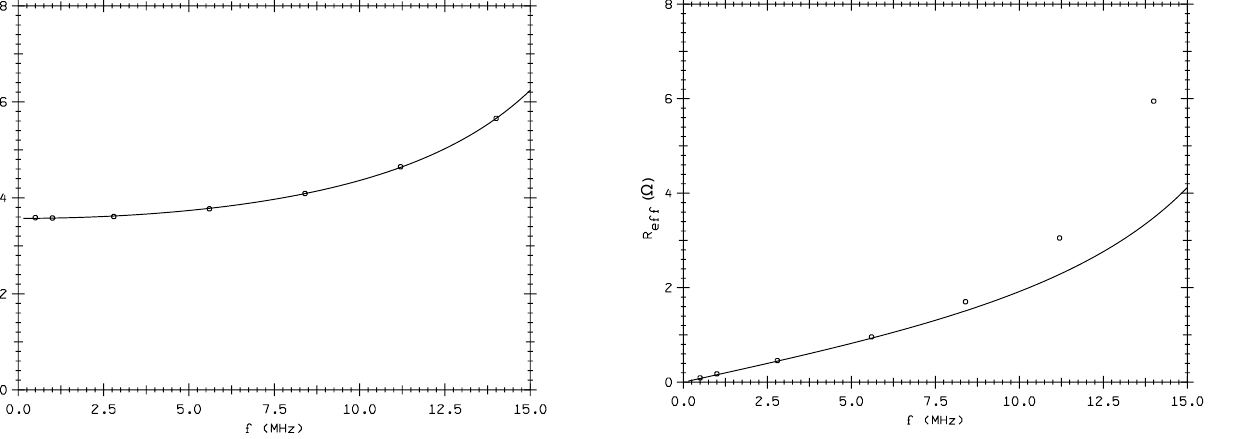
FIG. 8. Dependence of the real part of the impedance on frequency for one cavity with zero bias current. The solid curve is a fit to the lowest-frequency points assuming a constant negative imaginary part to the characteristic transmission-line impedance.